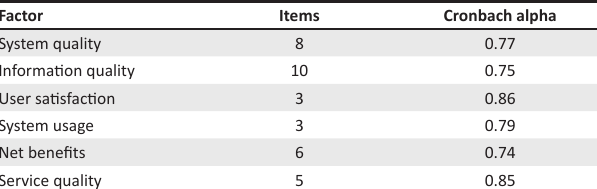
TABLE 2: Reliability tests.